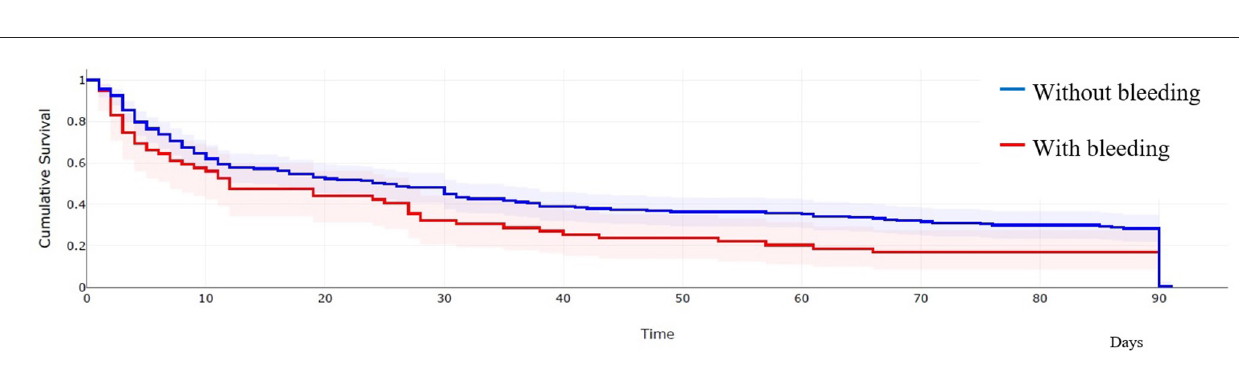
FIGURE6 Kaplan–Meier curve of the death given in days in patients with and without bleeding after